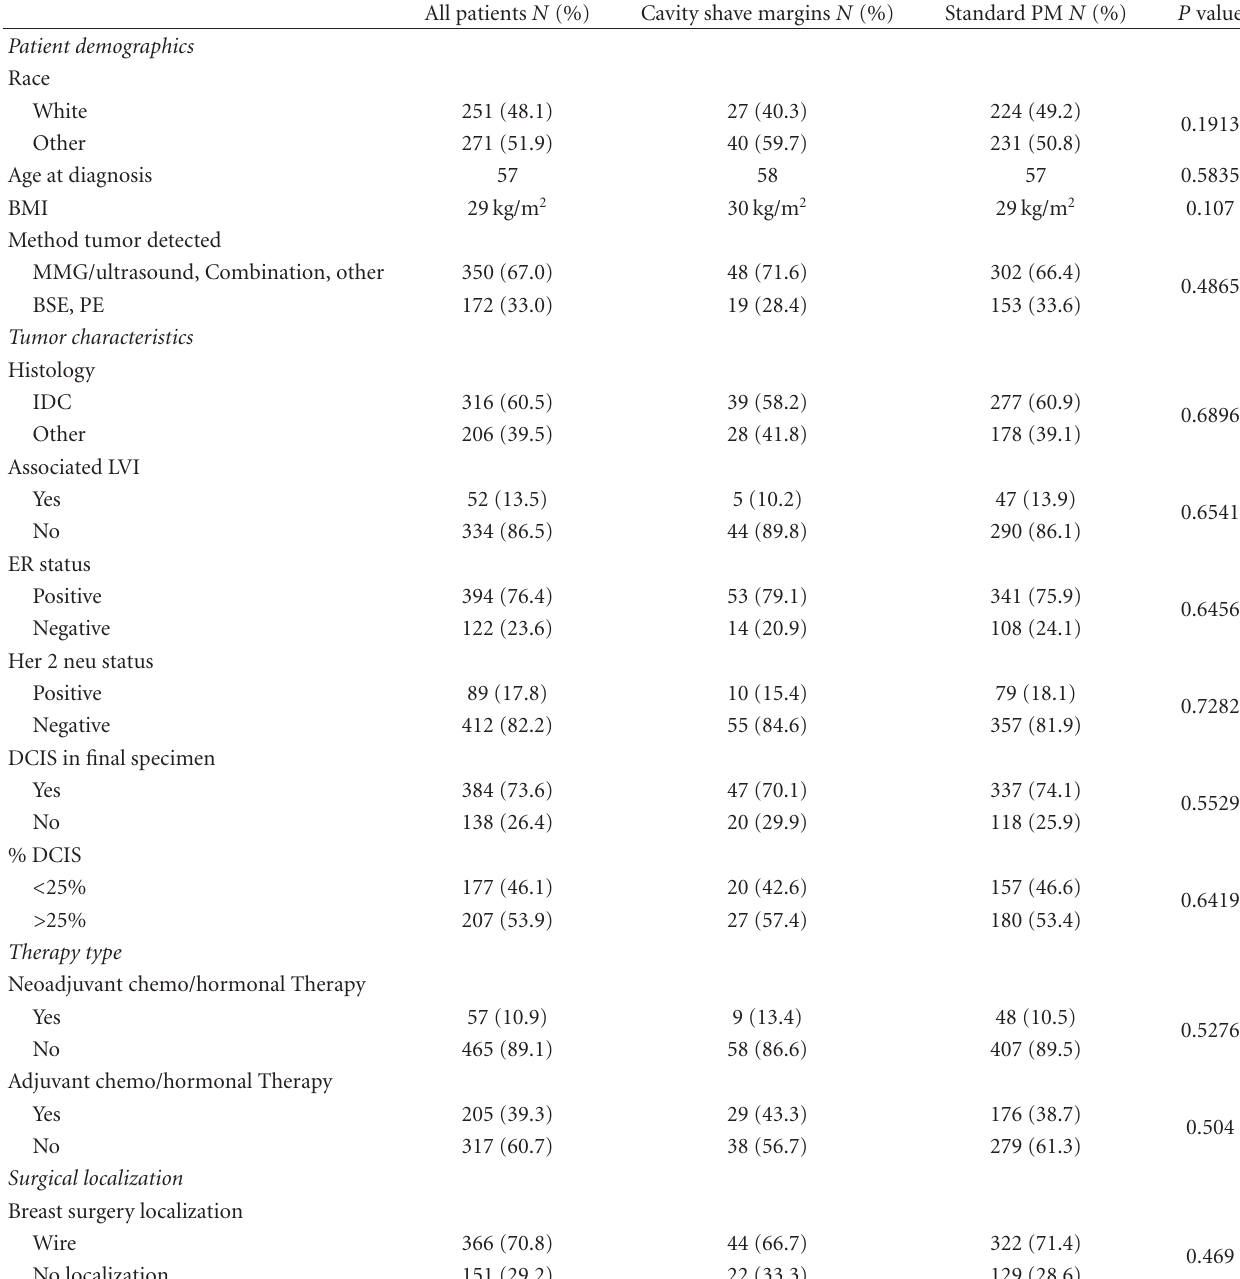
Table 1: Patient, tumor, and therapy